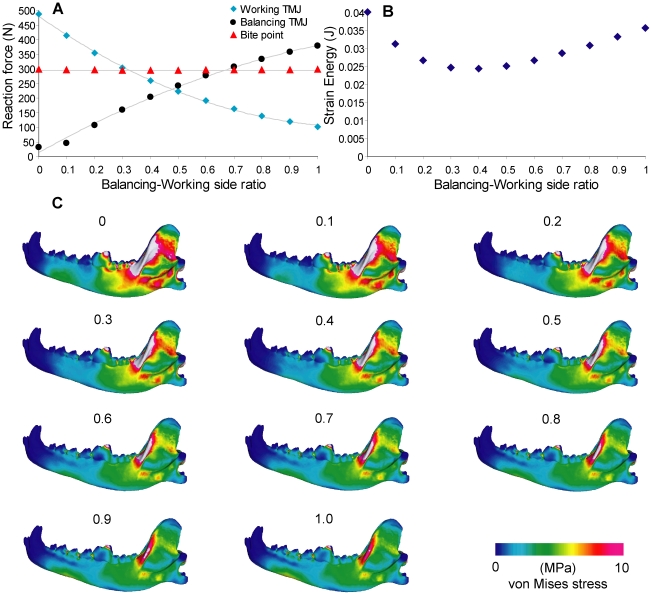
Sensitivity test on balancing-working side ratio.
A. Ratio plotted against reaction force, with second-order polynomial curves fitted onto the working and balancing reaction forces. B. Ratio plotted against strain energy. C. von Mises stress distribution in the working-side dentary in test models.